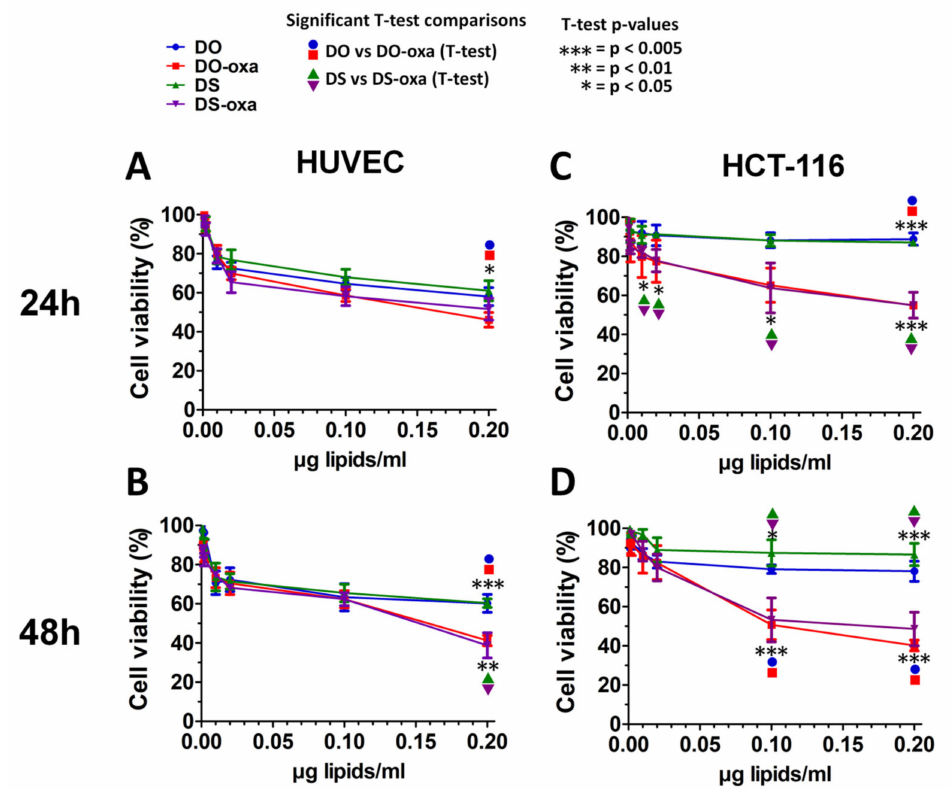
Figure 3. Viability of cells treated with liposomal formulations. Cell viability (%) was measured by 3-(4,5-dimethyl-2-thiazolyl)-2,5-diphenyl-2H-tetrazolium bromide (MTT) assay in human umbilical vein endothelial cells (HUVEC) at ( A ) 24 h and at ( B ) 48 h and in HCT-116 at ( C ) 24 h and at ( D ) 48 h. Controls are untreated cells and correspond to a cell viability of 100%. Experiments were performed in three independent replicates. Error bars represent standard deviations. Statistical significance was calculated by one-way two-tailed t